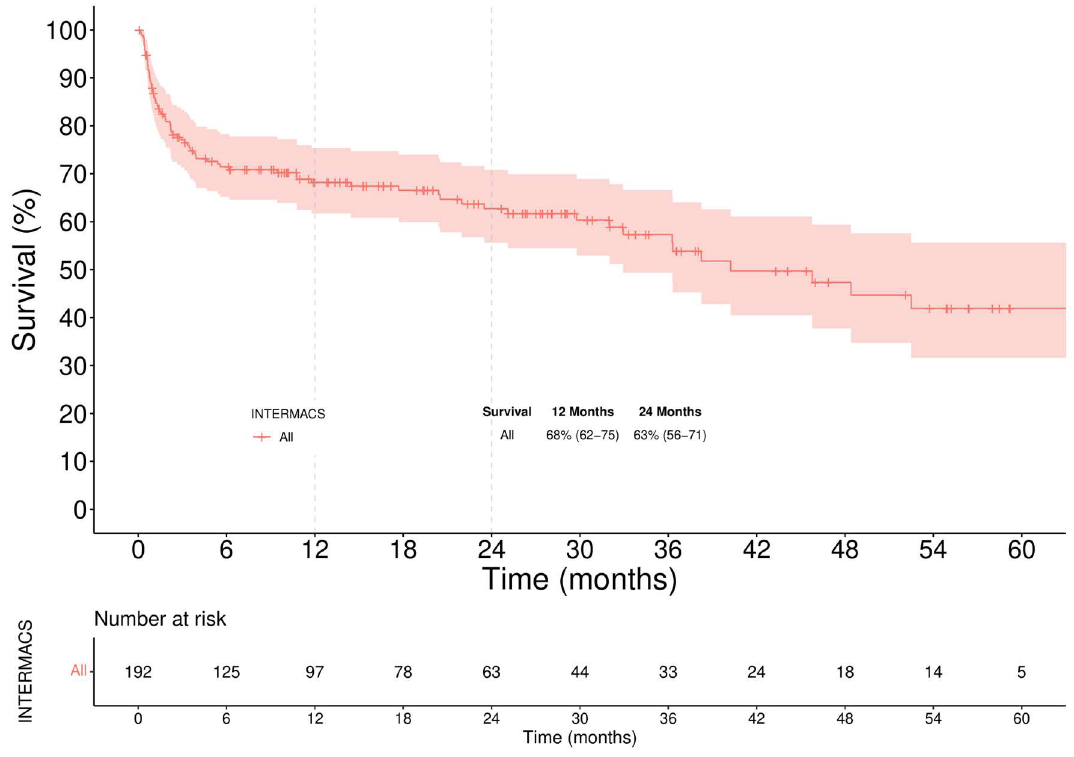
Figure 1. Overall Survival. Patients were censored at time of transplant or last follow-up.